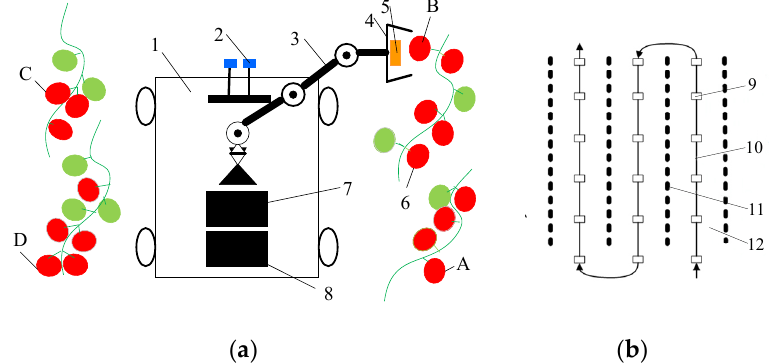
Figure 1. ( a ) “Global–local” visual servo picking system; ( b ) Cruise path of the robot. 1. Chassis; 2. Binocular vision system; 3. Manipulator; 4. End effector; 5. Monocular vision system; 6. Fruits; 7. Manipulator motion controller; 8. Chassis motion controller; 9. Stops during robot operation; 10. Cruise path of robot; 11. Tomato-planting ridge; 12. Aisle between ridges.